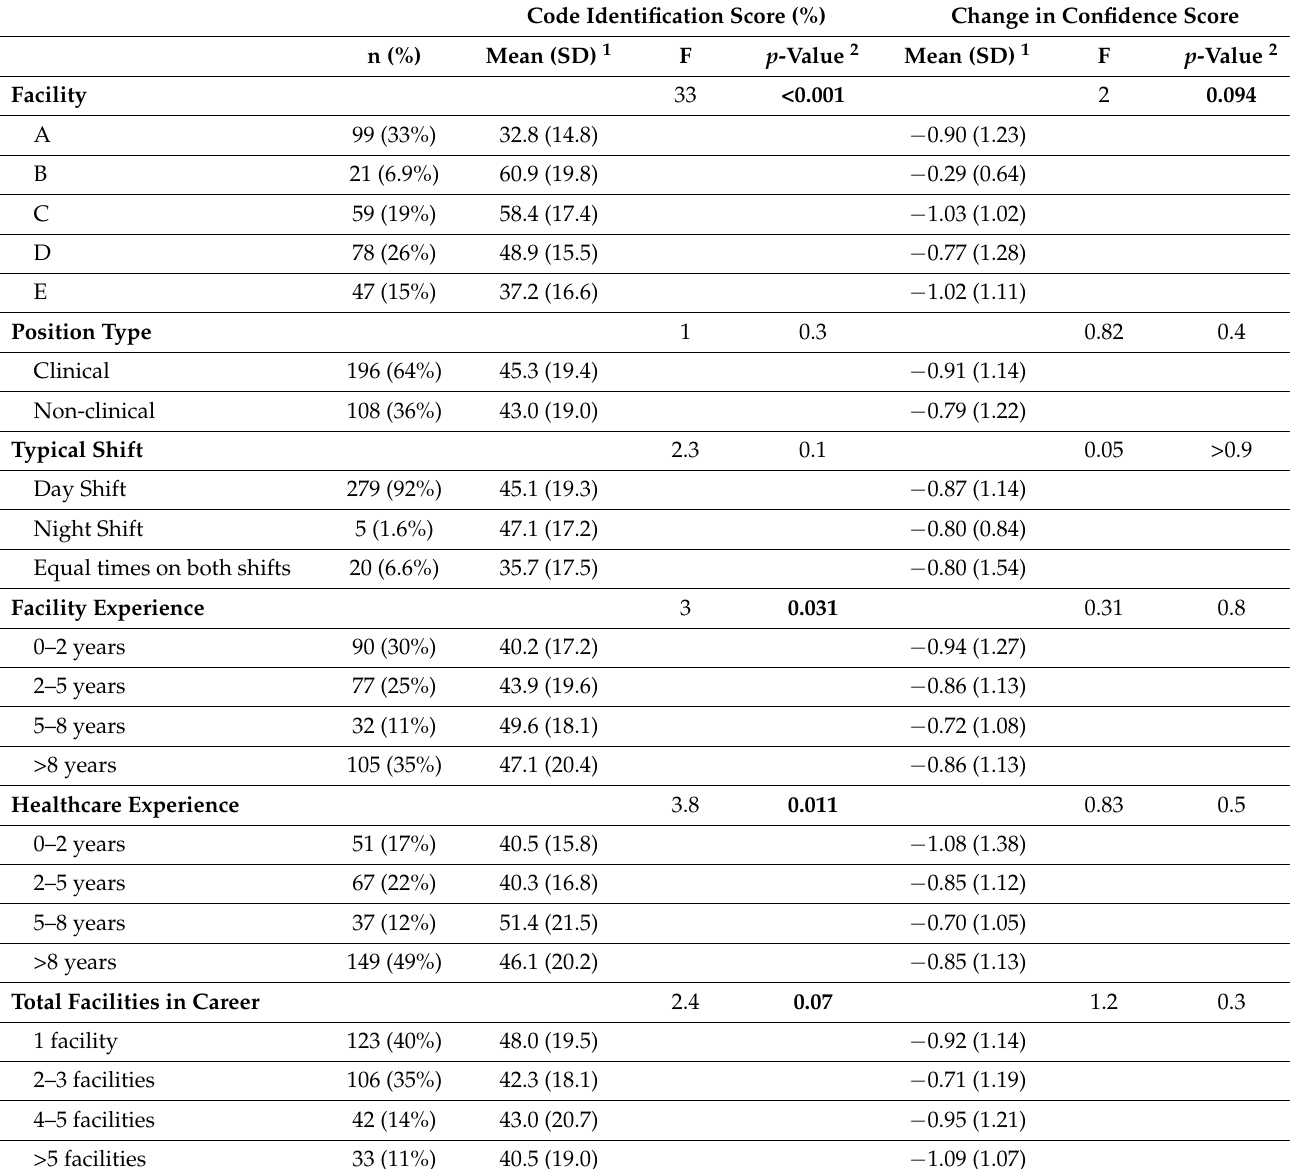
Table 4. Results of demographic characteristics one-way ANOVA tests with code identification and change in confidence score (N = 304). Significant p -values ( ≤ 0.05) are bolded. Code Identification Score (%) Change in Confidence